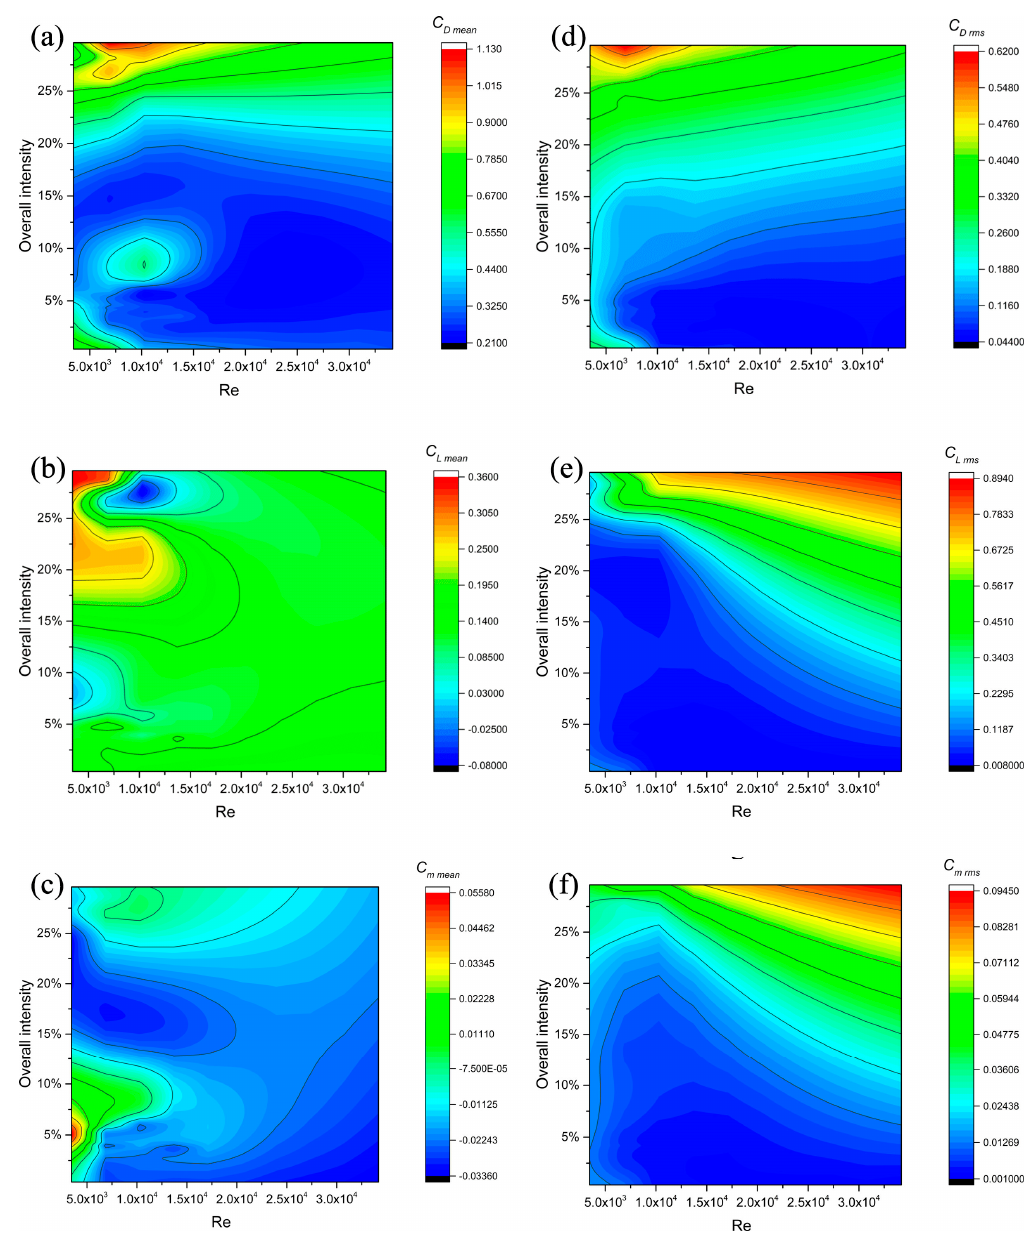
Figure 14. ( a – c ) The distributions of the time-averaged drag, lift, and moment, respectively, in the phase plane of Reynolds number and turbulence intensity. ( d – f ) The distributions of the fluctuating drag, lift, and moment, respectively, in the phase plane of Reynolds number and turbulence intensity.